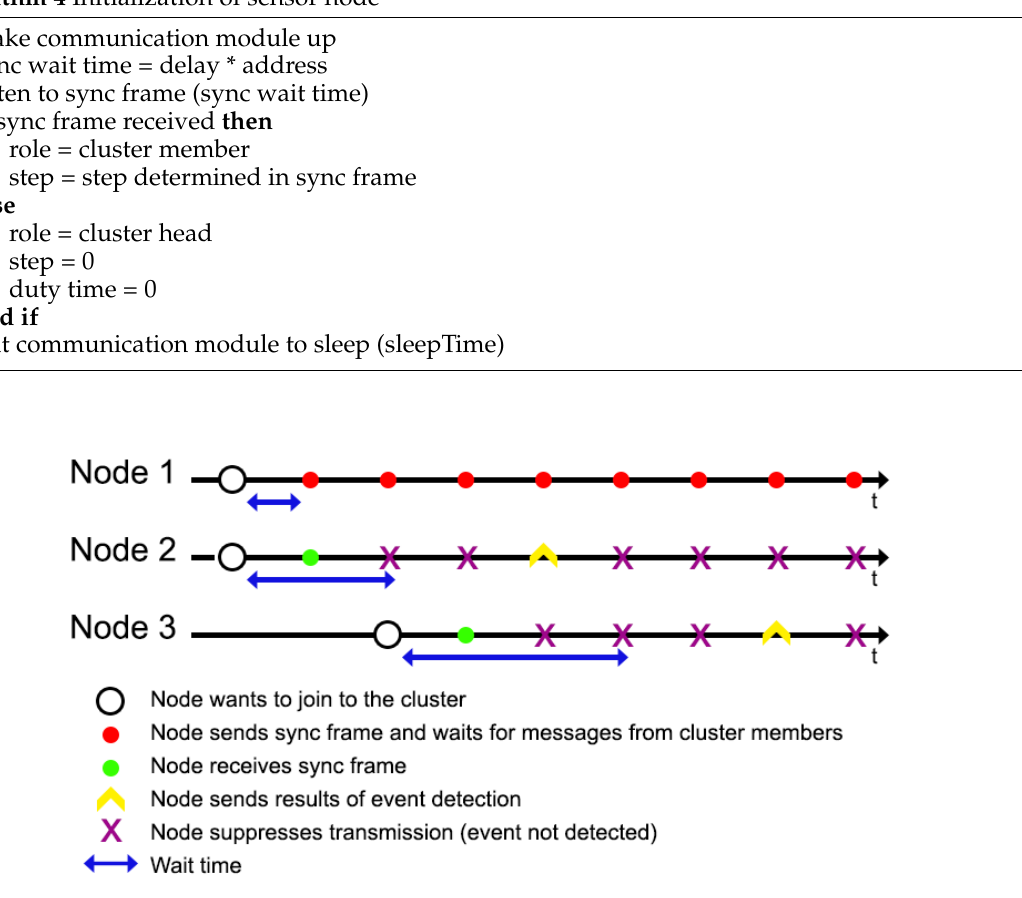
Figure 2. Initialization process for 3 nodes in WSN